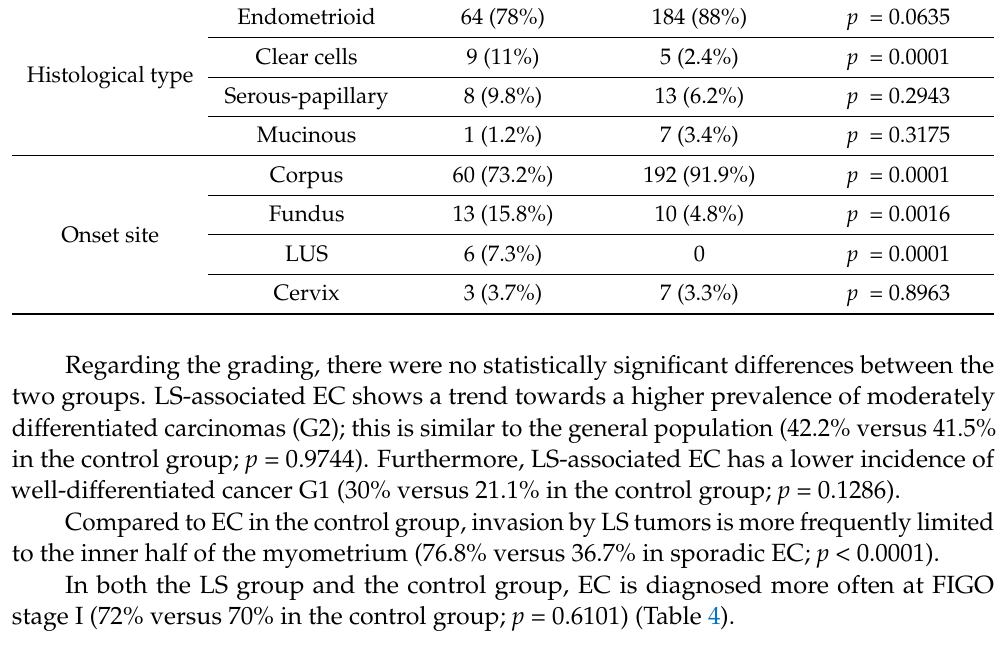
Table 4. FIGO (International Federation of Gynecology and Obstetrics) stage at diagnosis of EC in the LS group and in the control group.